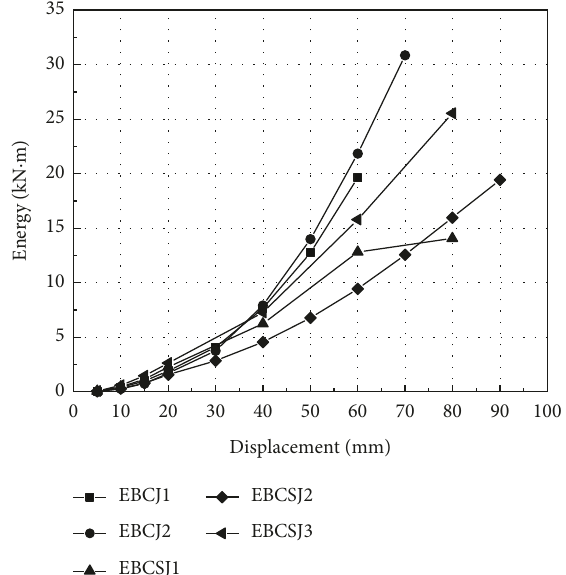
Figure 10: Energy dissipation of joint specimens.